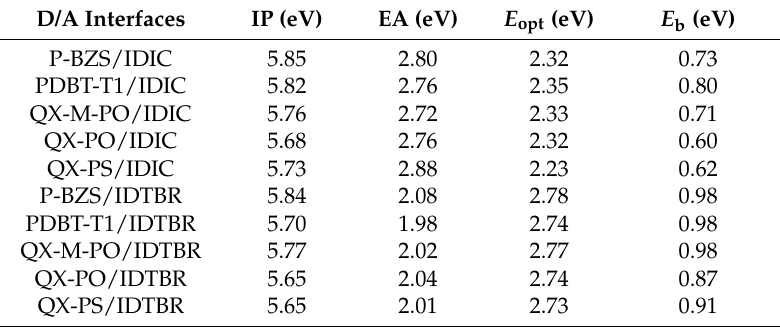
Table 9. The IPs, EAs, optical band gap energies ( E opt ) and exciton binding energies ( E b ) of D/A